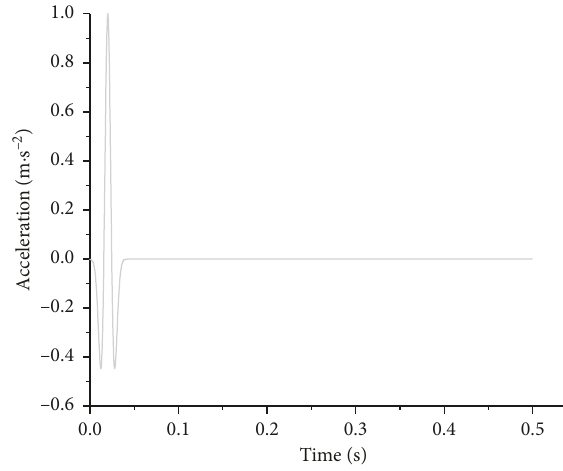
Figure 2: Ricker wavelet waveform